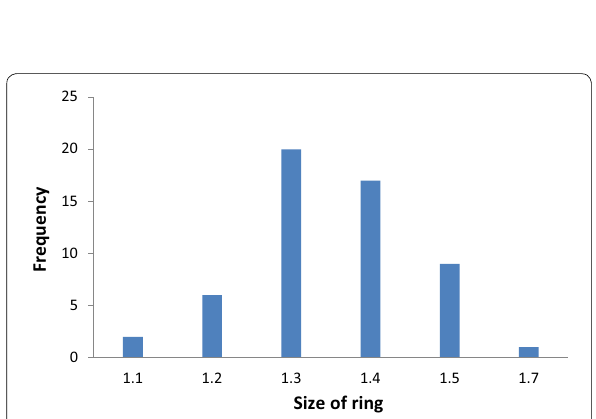
Fig. 5 Plastibell sizes (cm) used in circumcision